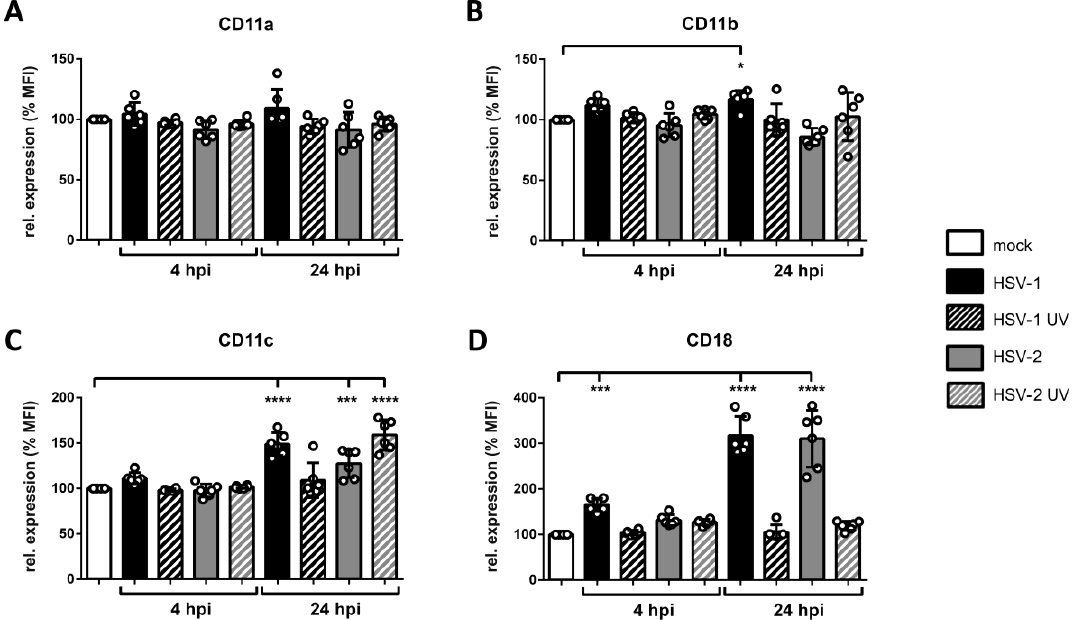
Figure 7. Expression levels of β 2 integrin subunits are di ff erentially regulated on HSV-2 infected mDCs 4 hpi and 24 hpi. Mock-, HSV-1- (MOI of 1), HSV-1 UV- (MOI of 1; 1.200 J / cm 2 ), HSV-2- (MOI of 5), or HSV-2 UV- (MOI of 5; 1.200 J / cm 2 ) infected mDCs were harvested 4 hpi and 24 hpi. Cells were stained with antibodies specific for ( A ) CD11a, ( B ) CD11b, ( C ) CD11c, or ( D ) CD18 and analyzed via flow cytometry. Panels show data as mean fluorescence intensity (MFI) for HSV-1- (black filled bars), HSV-1 UV- (black striped bars), HSV-2 (gray filled bars), or HSV-2 UV- (gray striped bars) infected mDCs relative to mock cells (white bars; set to 100%). Error bars indicate ± SD. Significant changes (**** = p < 0.0001; *** = p < 0.001; * = p < 0.05) are marked by asterisks. The experiment was performed six times with cells from di ff erent healthy donors.